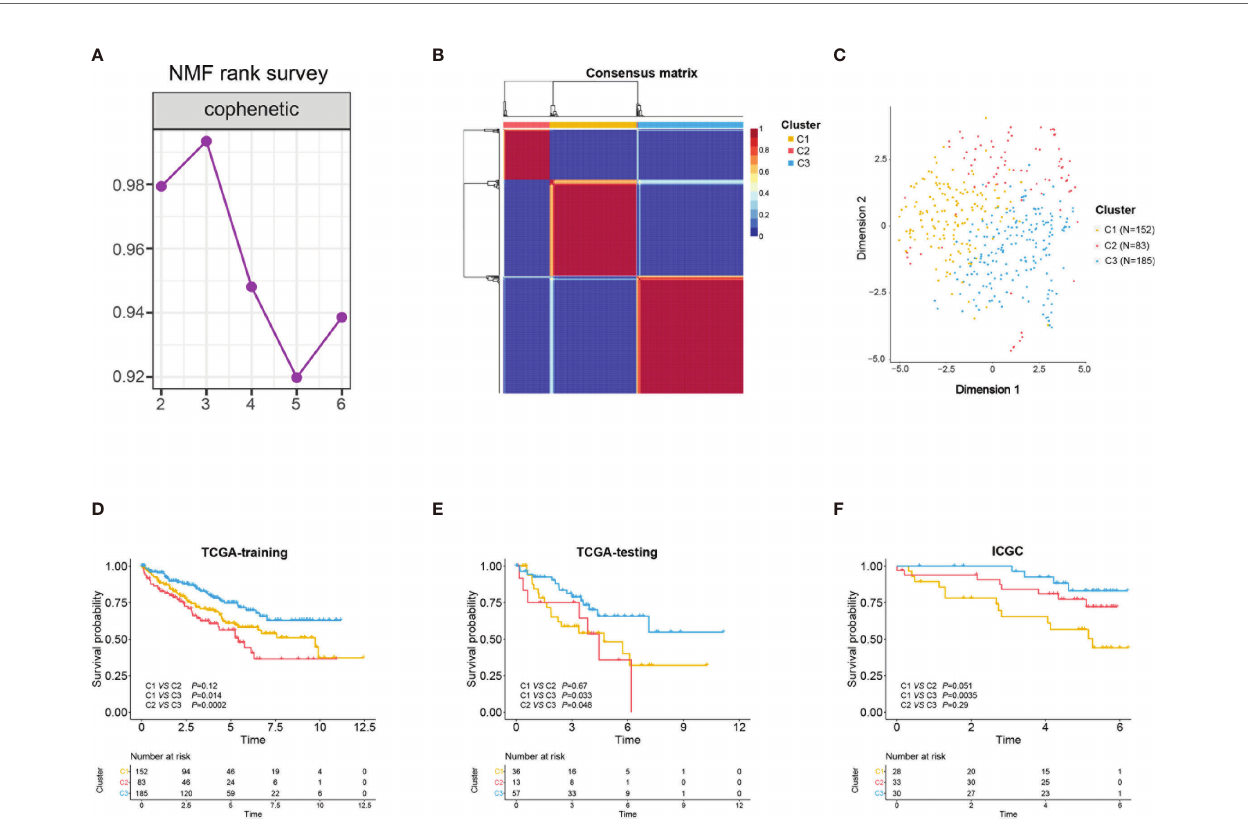
FIGURE 2 | Identi fi cation of three stem cell subtypes using non-negative matrix factorization (NMF) consensus clustering in clear cell renal cell carcinoma (ccRCC) The Cancer Genome Atlas (TCGA) training cohort. (A) NMF clustering using 392 stem cell-associated genes. Cophenetic correlation coef fi cients for k = 2 – 6 are shown. (B) Consensus heatmap for ccRCC samples when k = 3. (C) t -Distributed stochastic neighbor embedding (t-SNE) analysis supported the strati fi cation into three stem cell subtypes. Dots with different colors represent different samples in the subclasses. (D – F) Overall survival of the three subclasses (C1, C2, C3) in TCGA training and testing sets and the International Cancer Genome Consortium (ICGC)